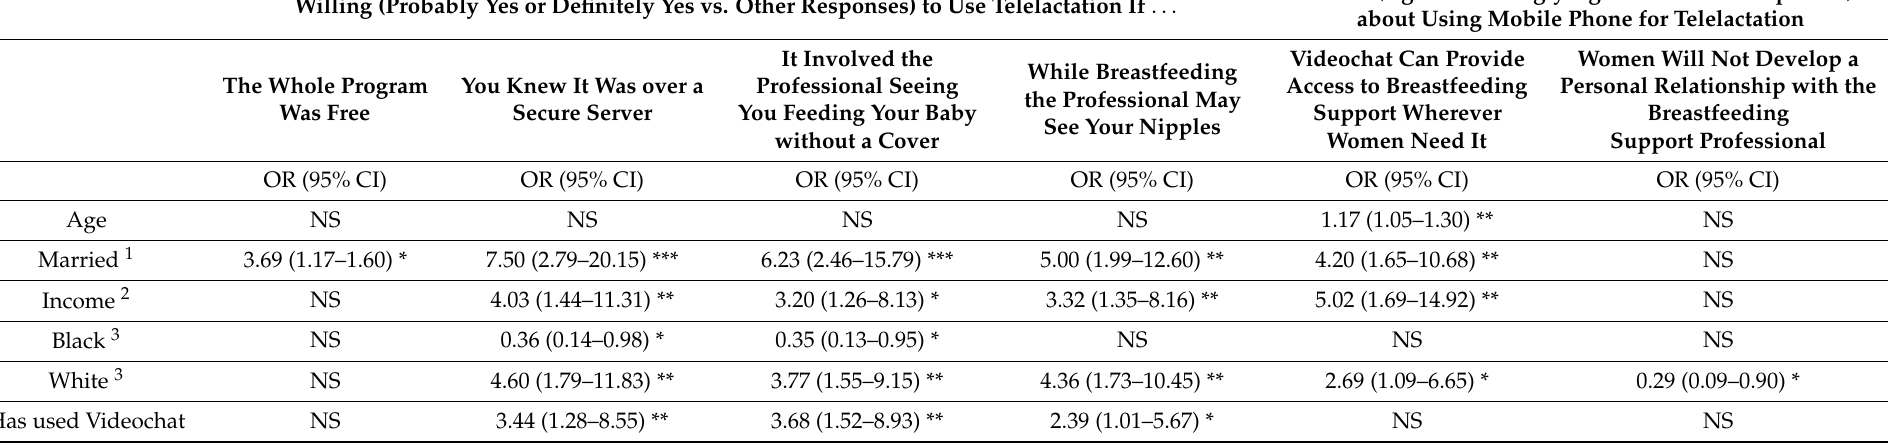
Table 3. Bivariate Associations between Participant Characteristics and Willingness or Beliefs Variables #